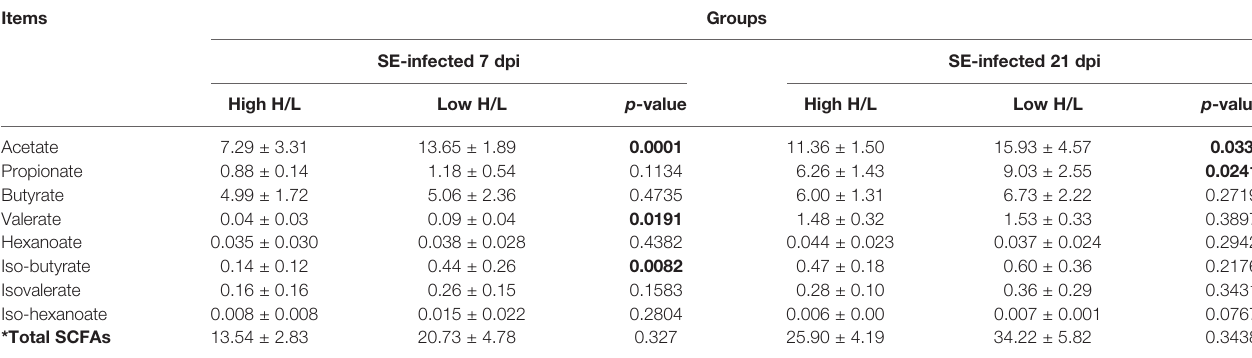
TABLE 1 | Effects of Heterophil/Lymphocyte ratio level on cecal SCFA contents of SE-infected chickens at 7 and 21 days post-infection (mmol/kg).